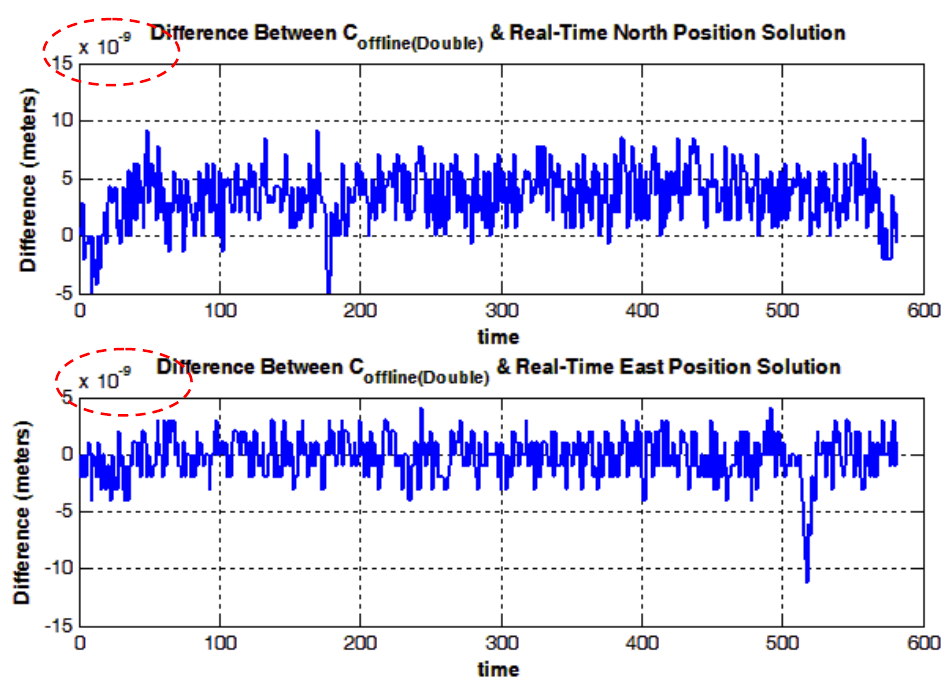
Figure 14. Mobile Robot Trajectory (1): Difference between C Double-Precision Offline and MicroBlaze Real-Time Solutions.